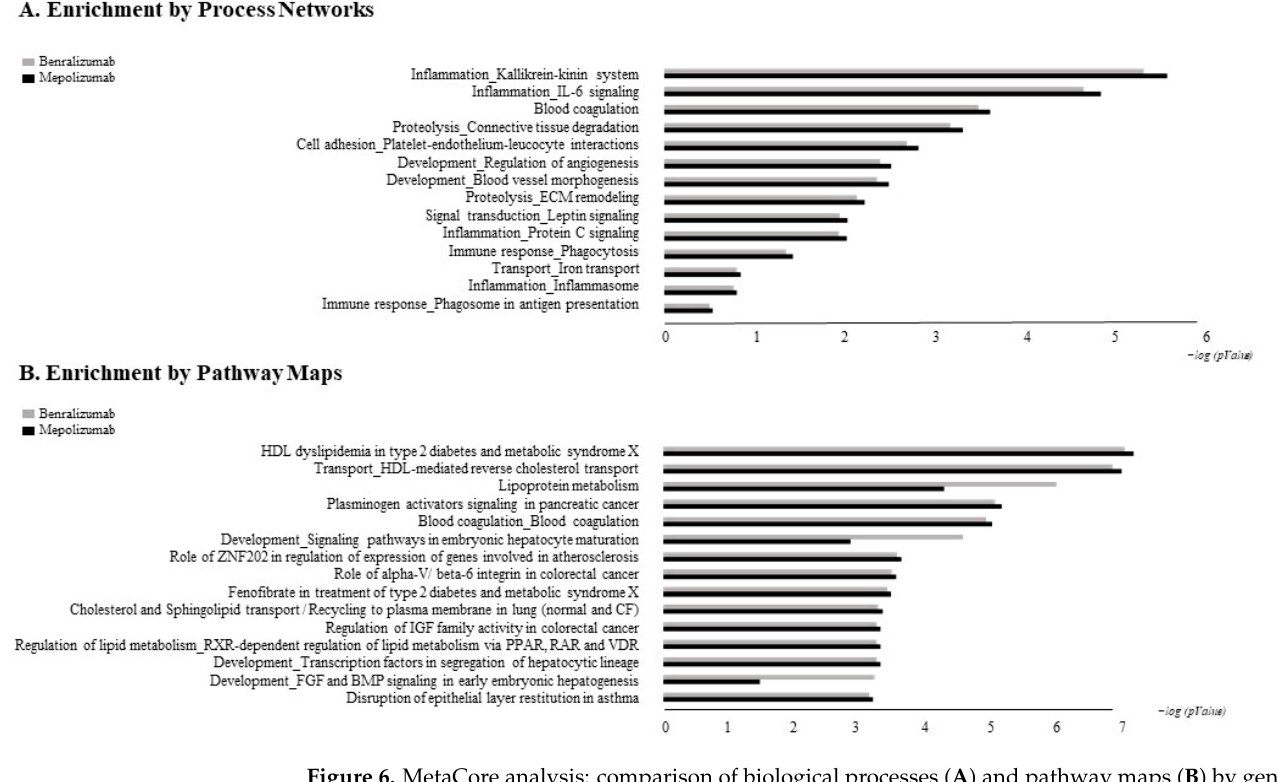
Figure 6. MetaCore analysis: comparison of biological processes ( A ) and pathway maps ( B ) by gene ontology differential proteins in benralizumab and mepolizumab time points. Black histograms show mepolizumab time points; grey histograms show benralizumab time points.